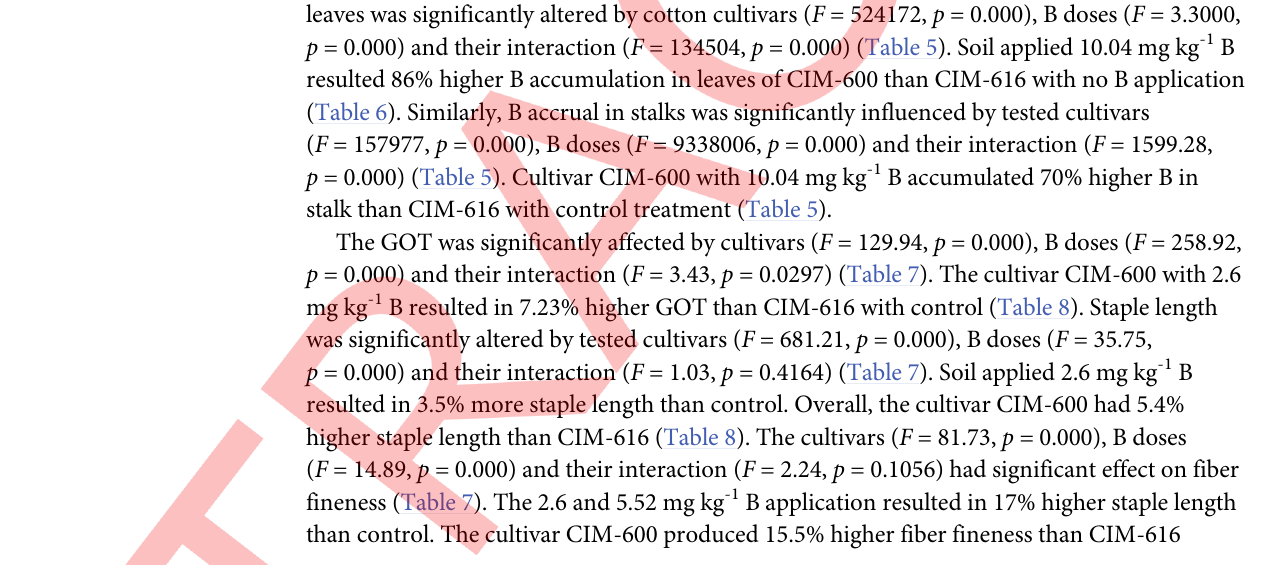
Table 6. Influence of different soil applied boron doses on boron uptake by roots, seed, leaves and stalk of cotton cultivars. B doses (mg kg -1